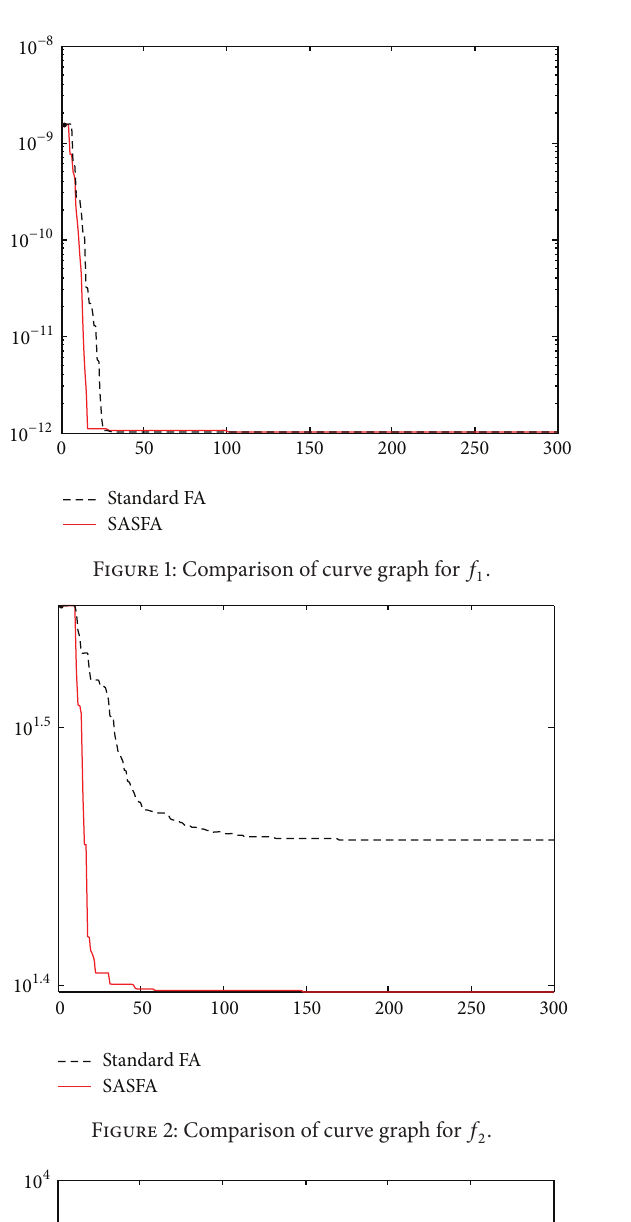
Figure 5: Comparison of curve graph for 𝑓 5 .